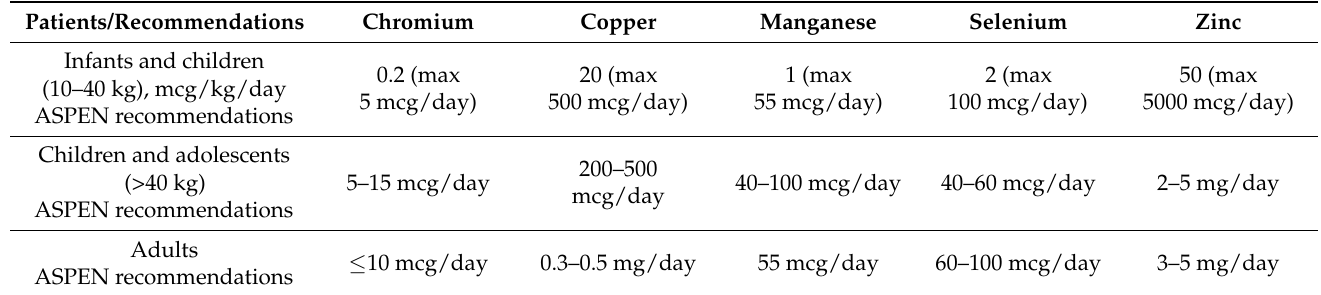
Table 3. Recommend daily amounts of TEs routinely included in PN [35,36].